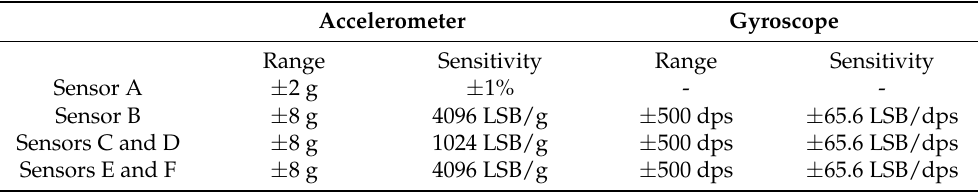
Table 1. The range and sensitivity of the used sensors